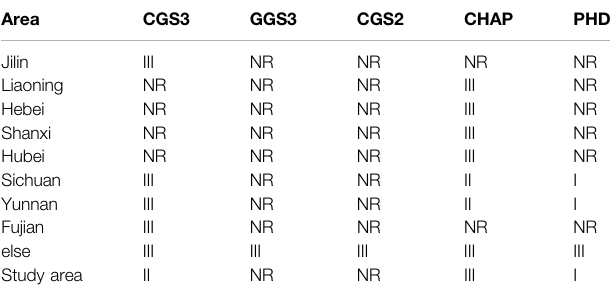
TABLE 2 | Selection suggestion of the PM 2.5 dataset for premature deaths.